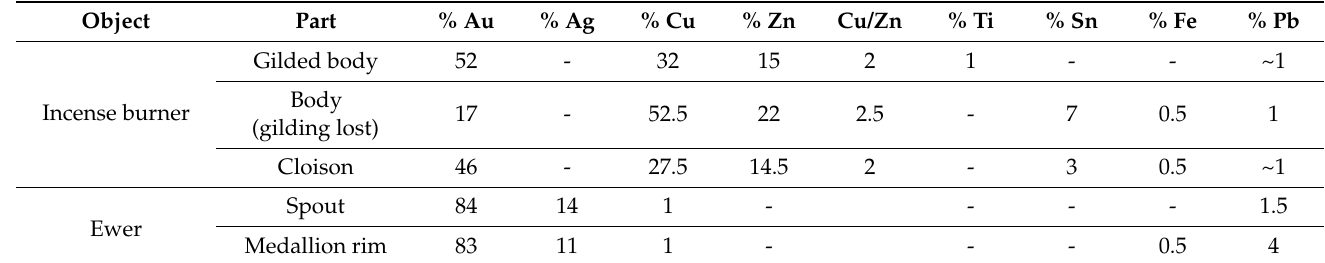
Table 1. Composition of the metal parts of the objects studied (metal